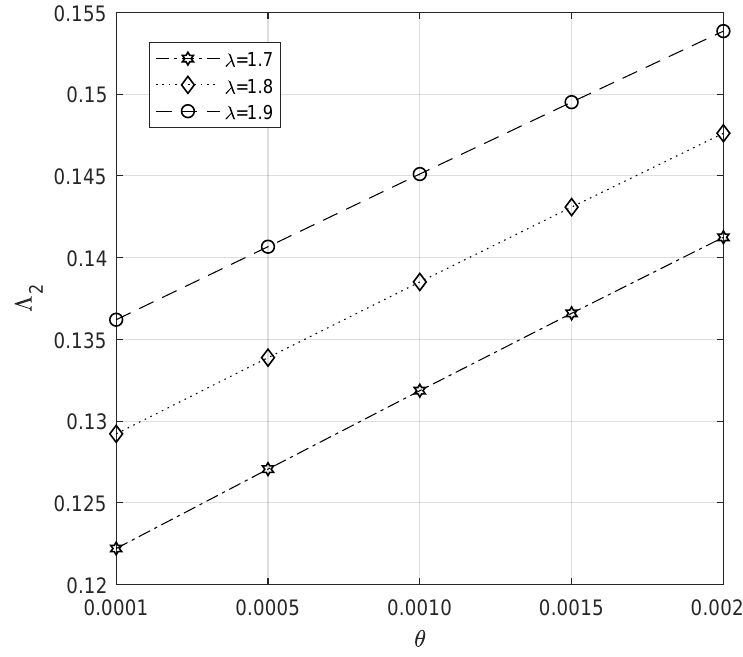
Figure 14. The impact of mean reorder rate when λ vs. θ